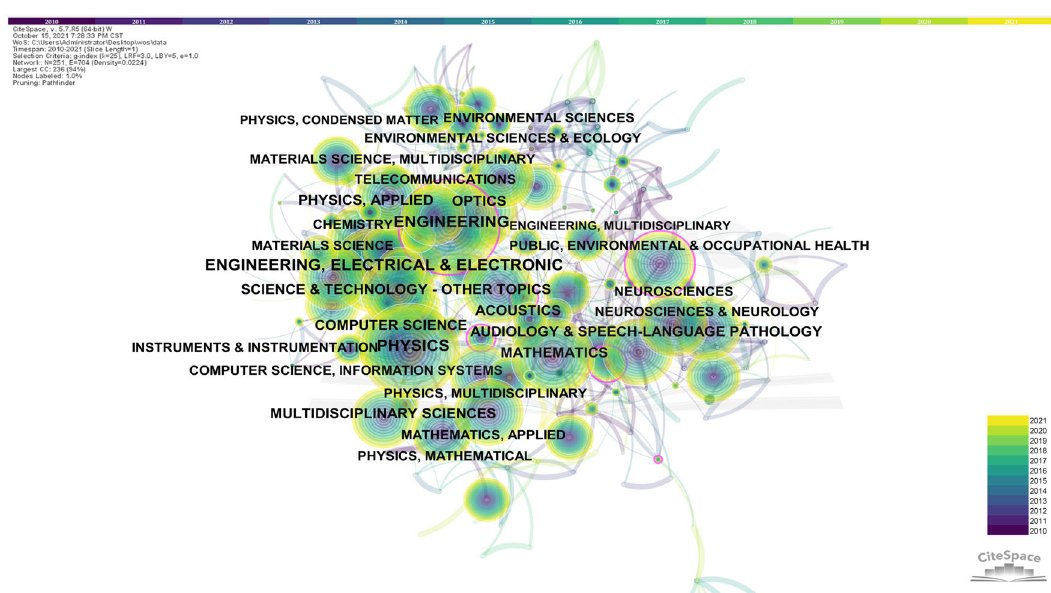
Fig. 2 Co-category network